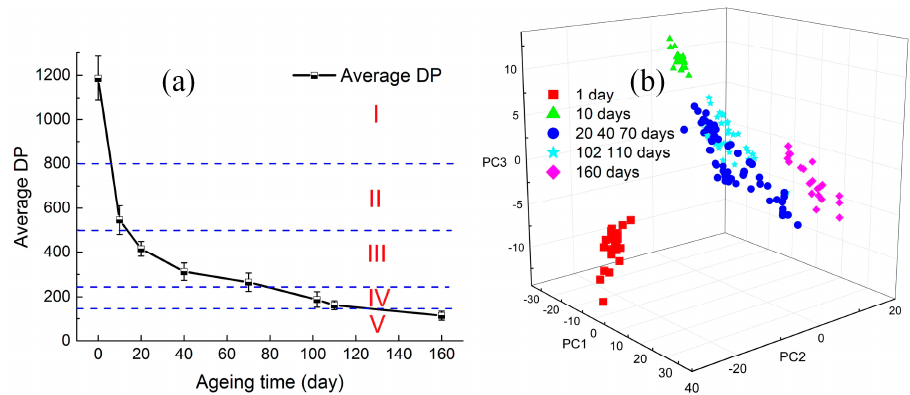
Figure 7. Classification result of training samples: ( a ) Relationship between DP and aging time; ( b ) Scatter plots of the PC scores for five classes of oil samples, with the PC scores derived from the Raman spectra.